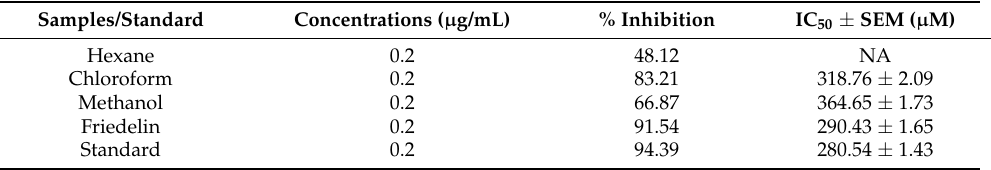
Table 3. β -Secretase-inhibiting effects of crude extract/fractions and compound 1 extracted from Syzygium cumini